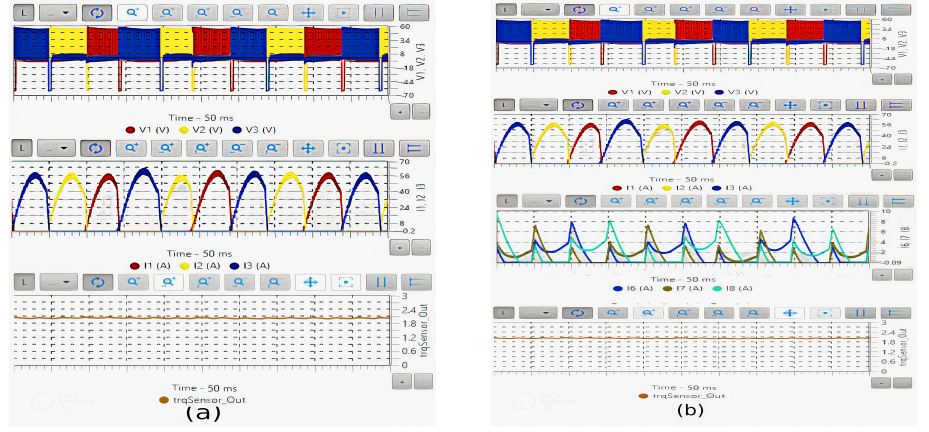
Figure 15. Closed-loop transient response at reference speed: ( a ) conventional SRM and ( b ) HESRM.